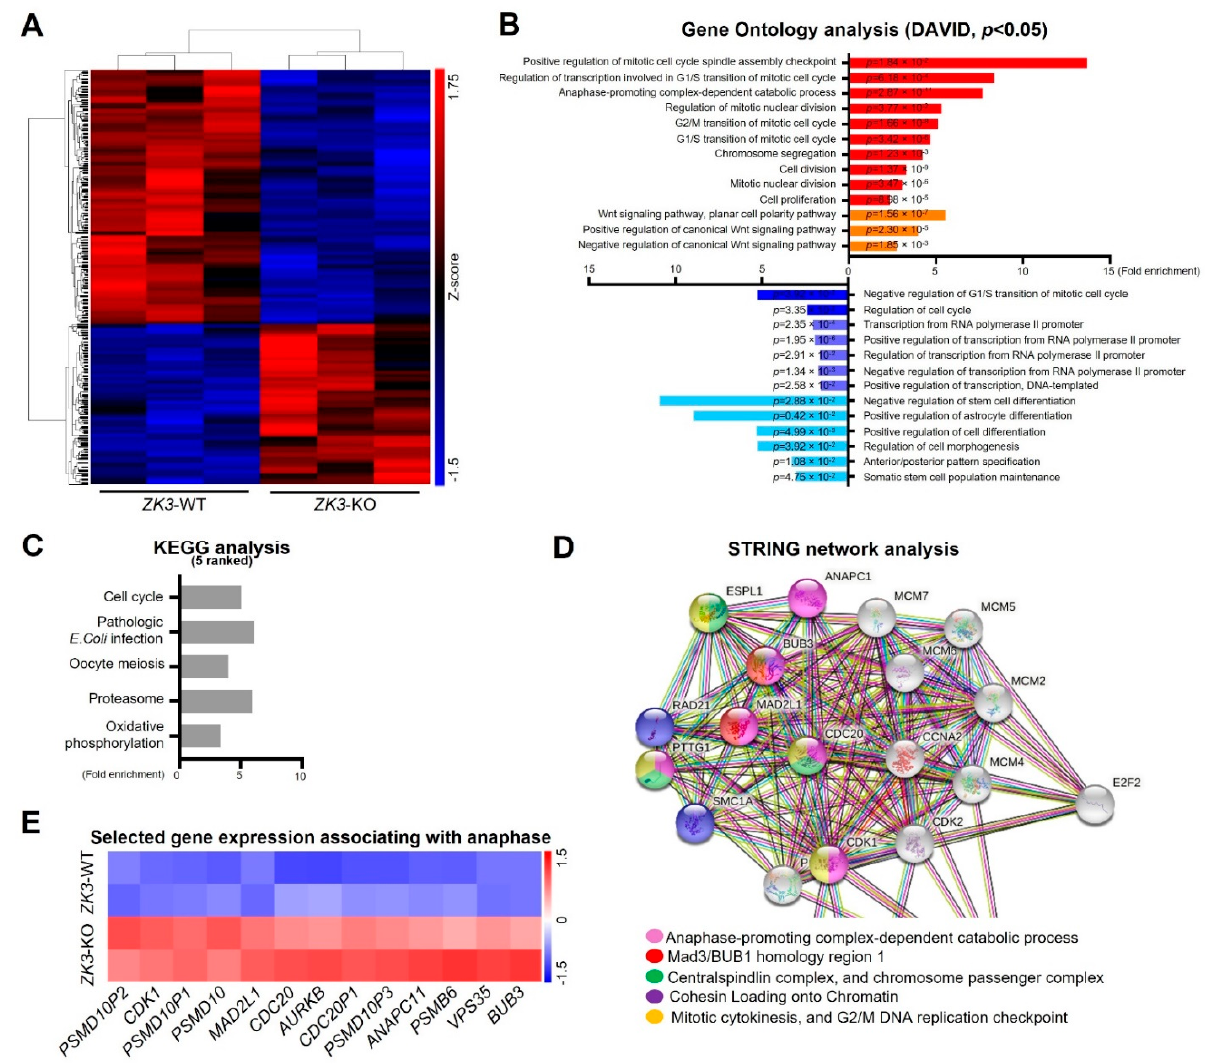
Figure 1. Transcriptome analysis of ZK3-KO cells versus reference cells. ( A ) Hierarchical clustering heat-map for DEGs of the ZK3-KO HCT116 and parental HCT116 cells. ( B ) GO analysis for biological processes. Red bars represent categories generated from upregulated genes, and blue bars are those from the downregulated genes. p -values are indicated. ( C ) Top 5 KEGG pathways in pathway enrichment analysis of the DEGs. ( D ) STRING network analysis of cell cycle-associated genes classified by GO analysis. ( E ) Heat-map plot comparing the transcription levels of genes involved in the regulation of anaphase, based on the RNA sequencing results. GO, gene ontology; DEGs, differentially expressed genes; KEGG, Kyoto Encyclopedia of Genes and